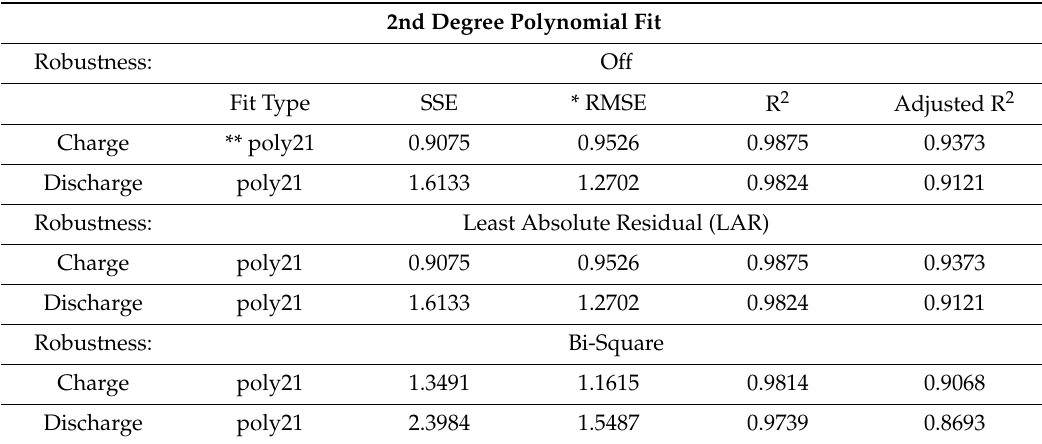
Table 7. Comparison of Various Fitness Parameters for the Developed Regression Model.